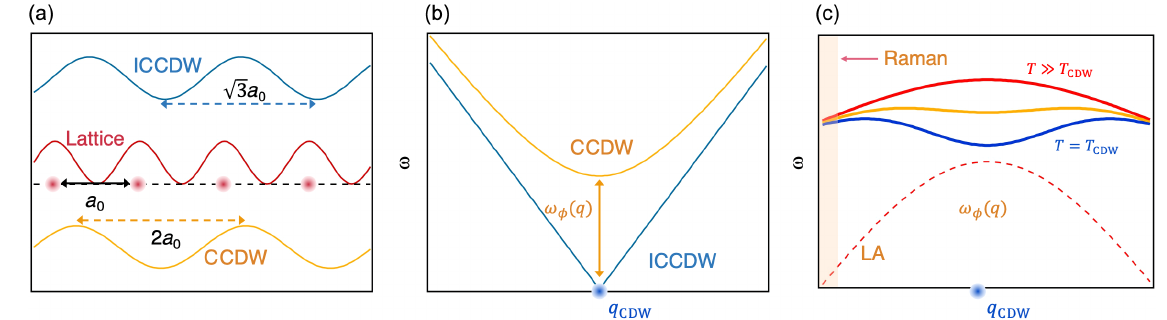
FIG. 6. (a) schematically shows commensurate (yellow) and incommensurate (cyan) CDW periods with respect to the lattice (red). (b) Yellow and cyan curves are the calculated phase modes for CCDW and ICCDW, respectively. (c) shows the CDW mechanism without electron-acoustic phonon interaction. The temperature-dependent particle-hole excitations are shown as red, yellow, and blue curves. The dashed line show the LA mode, whose energy at q is less than ω ϕ . Shaded pink area indicates the momentum position of CDW the Raman